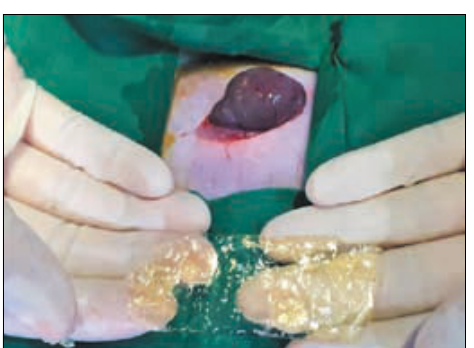
Fig. 4 . Application of pectin-honey hydrogel